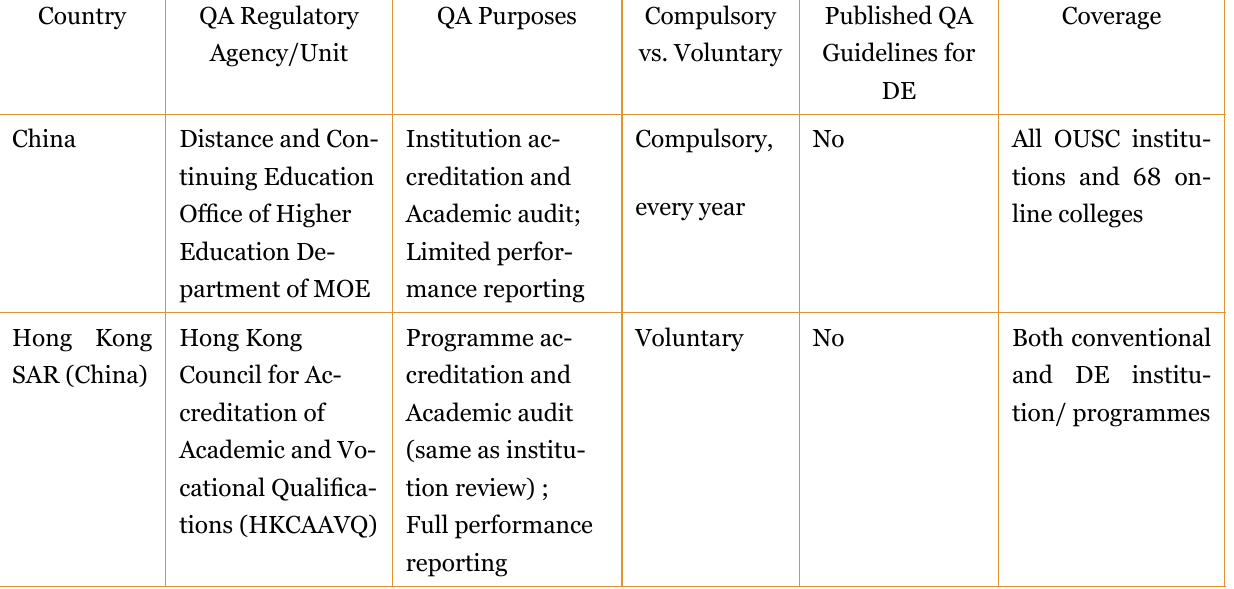
Features of QA Regulatory Accreditation Agencies in 11 Asian Countries/Territories